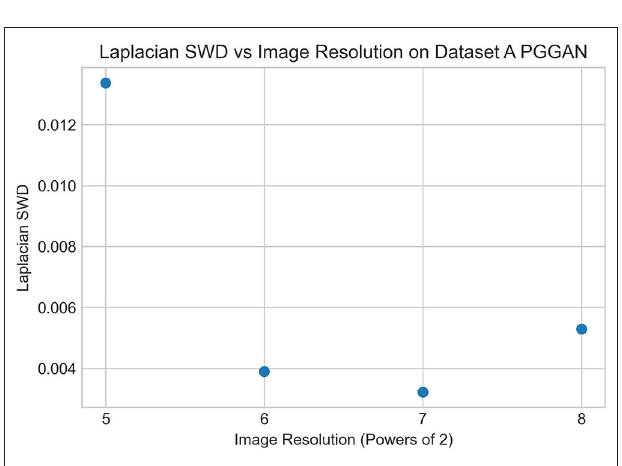
FIGURE 8 | Laplacian SWD scores for the PGGAN trained on Dataset A.